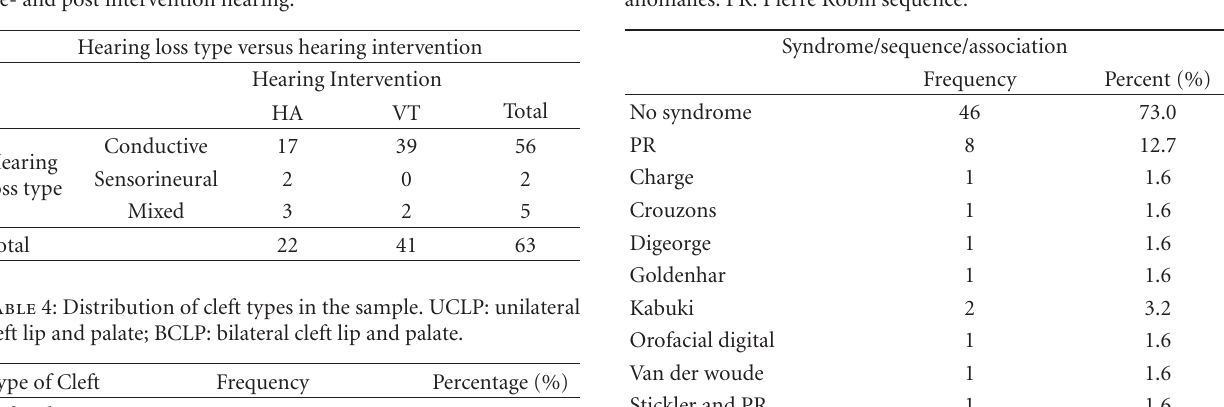
Table 3: Comparing treatment outcomes by way of di ff erences in pre- and post intervention hearing.